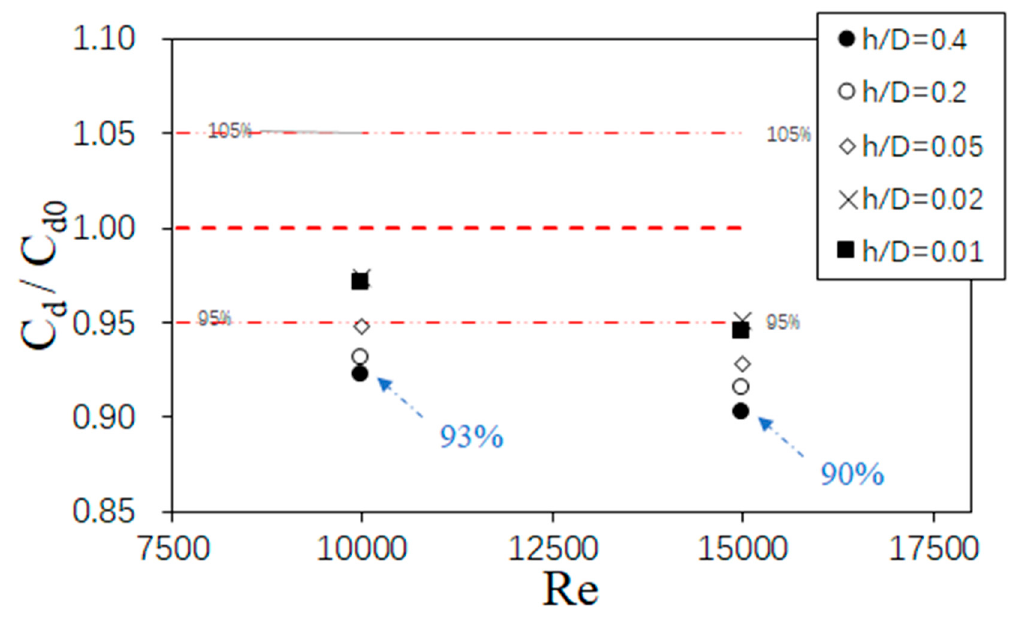
Figure 10. Discharge coefficient ratio as dependent upon Re j ranging from 7500 to 15,000 for different micro cooling units heights.